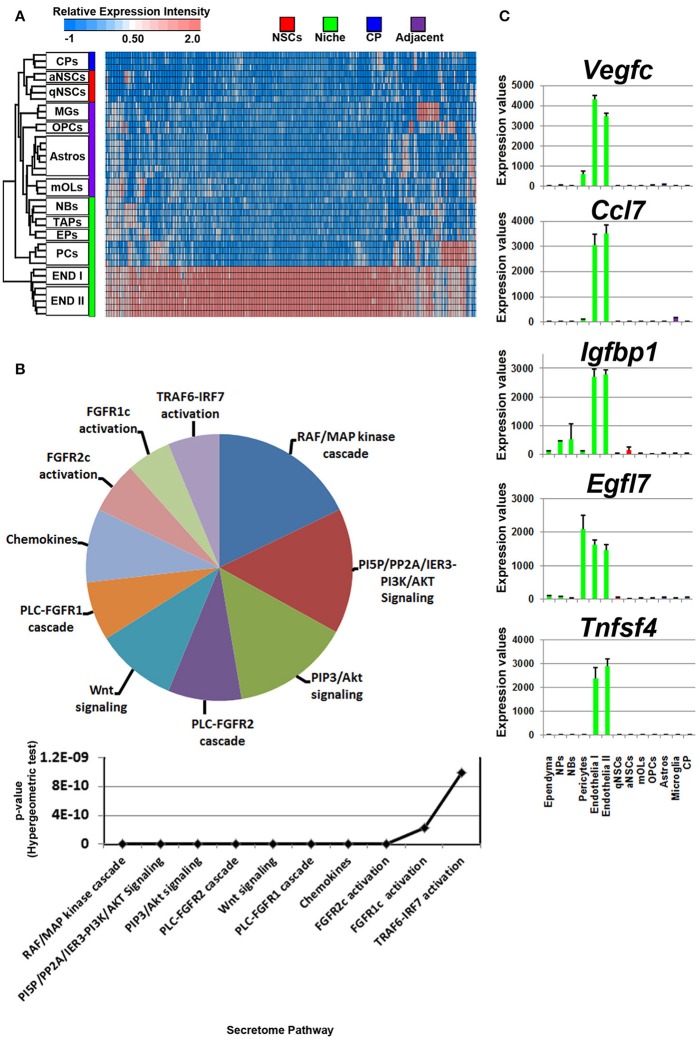
Ligand mRNA enrichment in cells that constitute the niche. (A) The transcriptome of ligand mRNA significantly enriched (1.8 fold change; p < 5% FDR) in the cells derived from the niche are displayed as a heatmap and plotted with the remaining datasets. The majority of ligand mRNA detected in this analysis is derived from endothelia. (B) These were further characterized using Reactome Pathway for classifying broadly the functions and signaling networks of ligand mRNA detected in the analysis and their p-values plotted below as a histogram. (C) The top most enriched genes are shown in histograms with in their antilog expression values across multiple cell types showing overall elevated expression in different glial cells. Red, green, blue and purple colors used are for groups containing NSCs, niche, choroid plexus and adjacent glial cells, respectively. CP, choroid plexus; aNSCs, active neural stem cells; qNSCs, quiescent neural stem cells; MGs, microglia; OPCs, oligodendrocytes precursor cells; Astros, astrocytes; OLs, oligodendrocytes (mature); NBs, neuroblasts; TAPs, transiently amplifying progenitors; EPs, ependymal; PCs, pericytes; END I, Endothelia 1; END II, Endothelia 2.